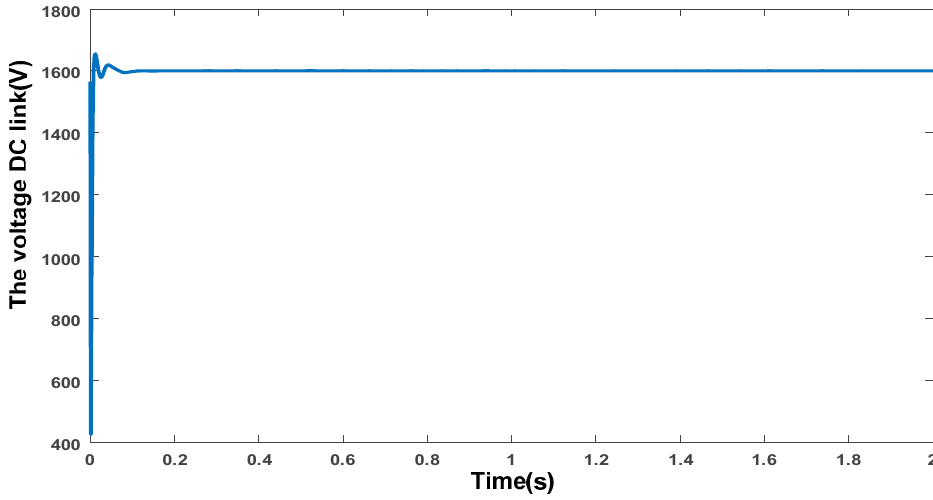
Figure 24. The voltage DC link of the MMC with an imbalanced load.